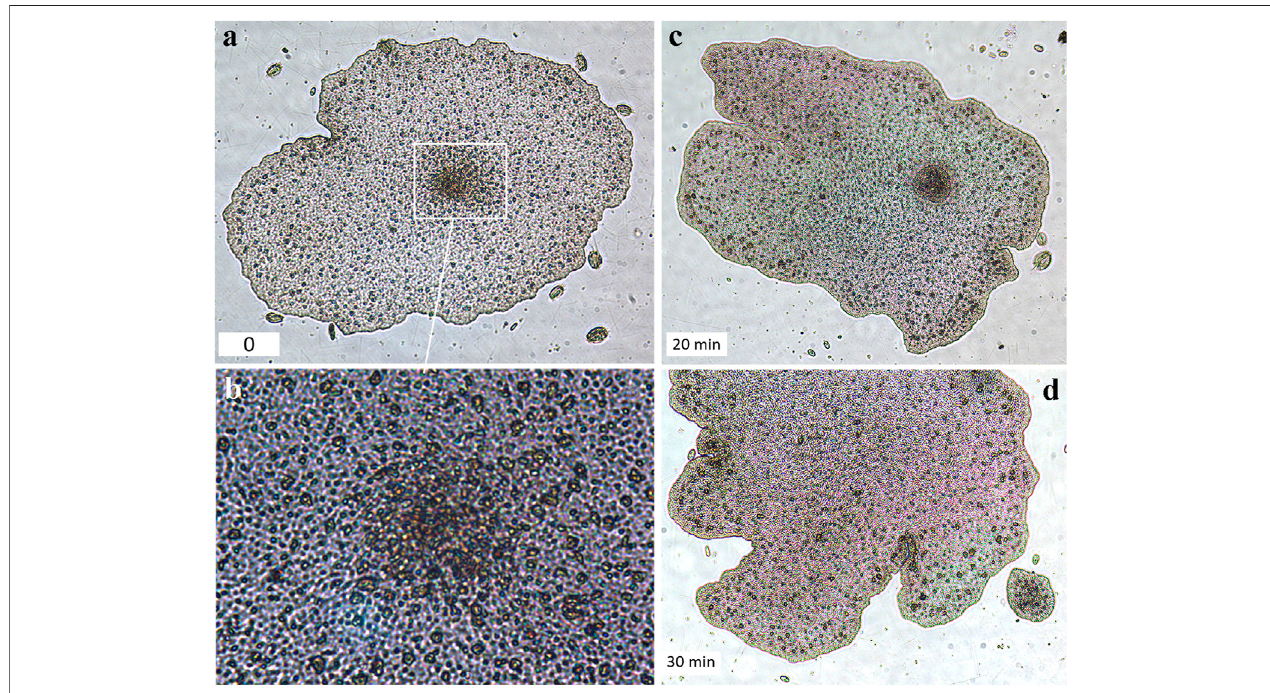
FIGURE 4 | Swarmer-like forms were formed at the lower (substrate-facing) side of the “ mother ” -animal (H1 haplotype, T. adhaerens ). (A,C,D) — A unique illustrated exampleoftheswarmerformation ’ stimecourse(bottomleftcornersindicatetimeintervalsinminutes). (A) .Theformationofahigherdensitycellregioninthemiddlepartofthe mother animal (white square outline, and the higher magni fi cation of the same region in (B,C) . The formation of the swarmer and its separation from the mother animal (D) .